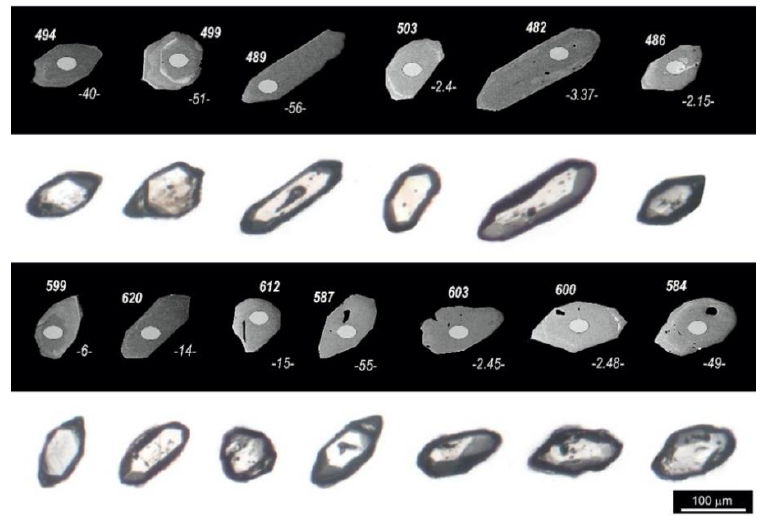
Figure 9. BSE images and optical photomicrographs of analysed zircons from Gu-35-2 sample (mylonitic migmatite). Ellipses mark analytical spot locations and the text shows spot names (italics) and 208 Pb/ 236 U age in Ma (bold).